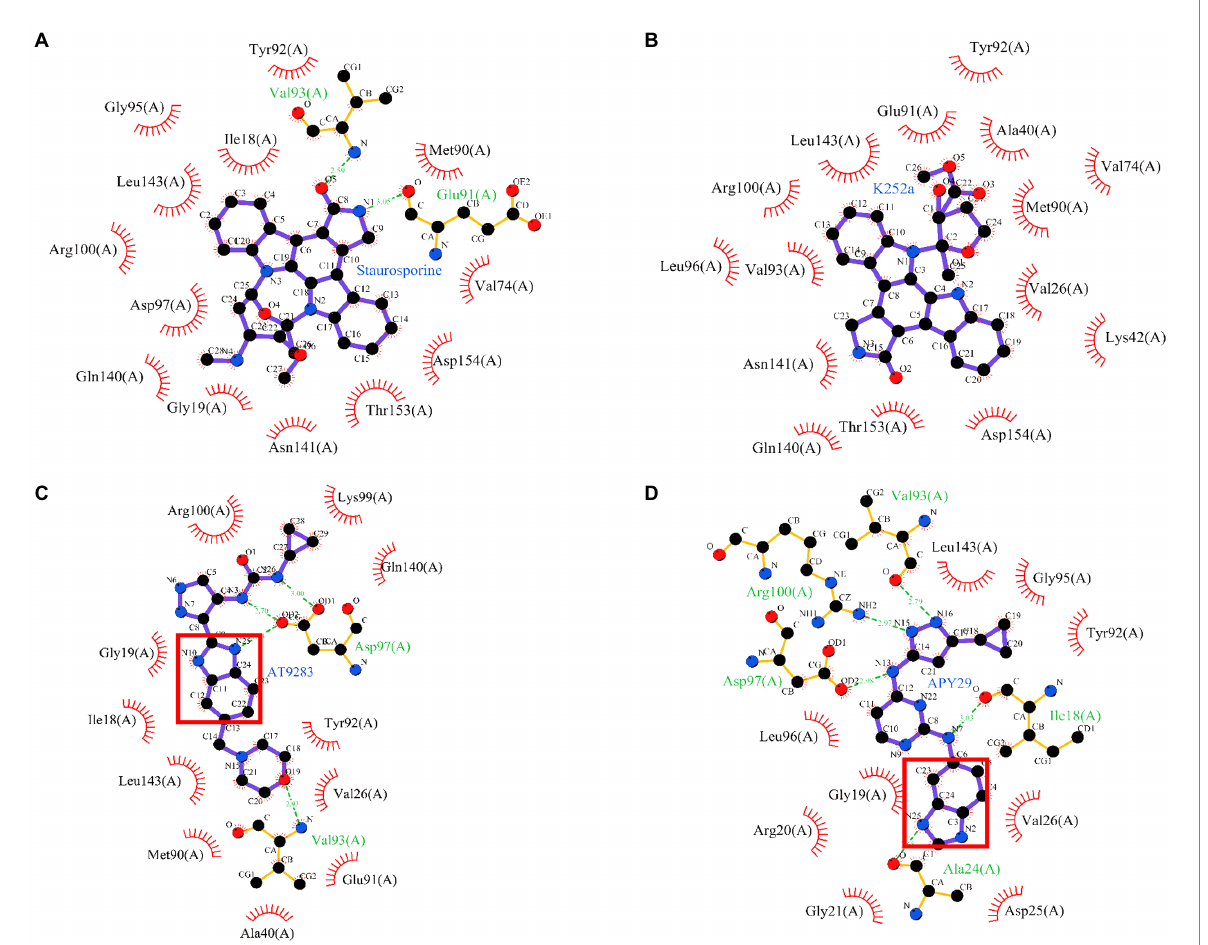
FIGURE 8 Molecular docking. Staurosporine (A) , K252a (B) , AT9283 (C) , and APY29 (D) were docked into the ATP-binding pocket of ssSTK using autodock4 software, respectively. The complex models were shown using Ligplus software (version 2.2.), Benzimidazole nucleus was marked by red